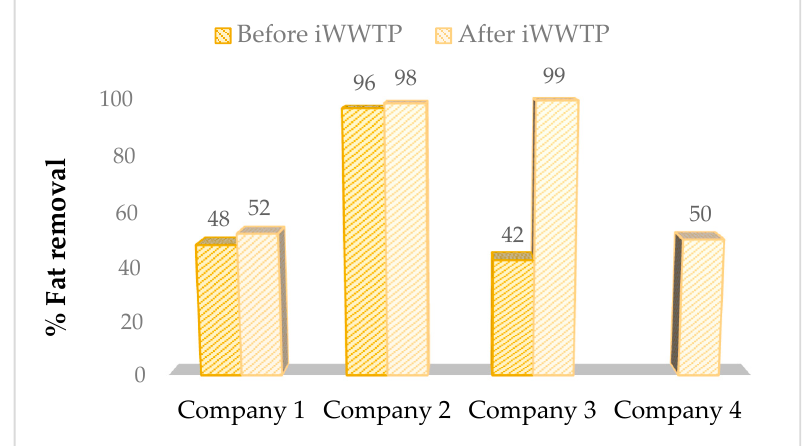
Figure 6. % Fat removal before and after the iWWTP.